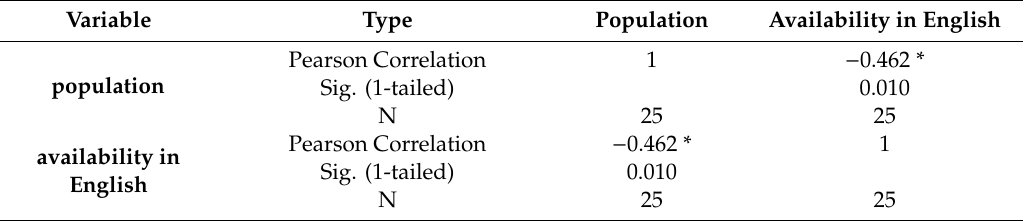
Table 5. Pearson correlation coe ffi cient between (population—availability in